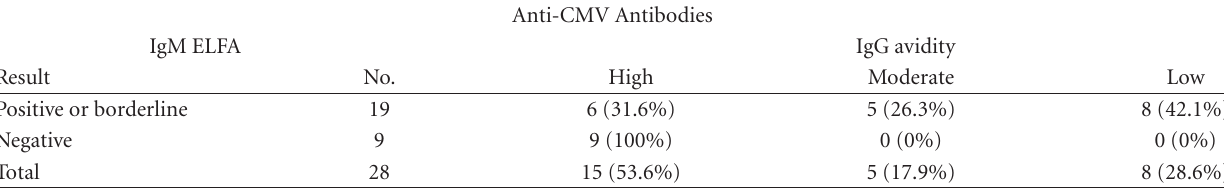
Table 3: IgM, ELFA, and IgG avidity results in pregnant women positive for the ELISA detection of IgM anti-CMV antibodies (2005–2007). Anti-CMV